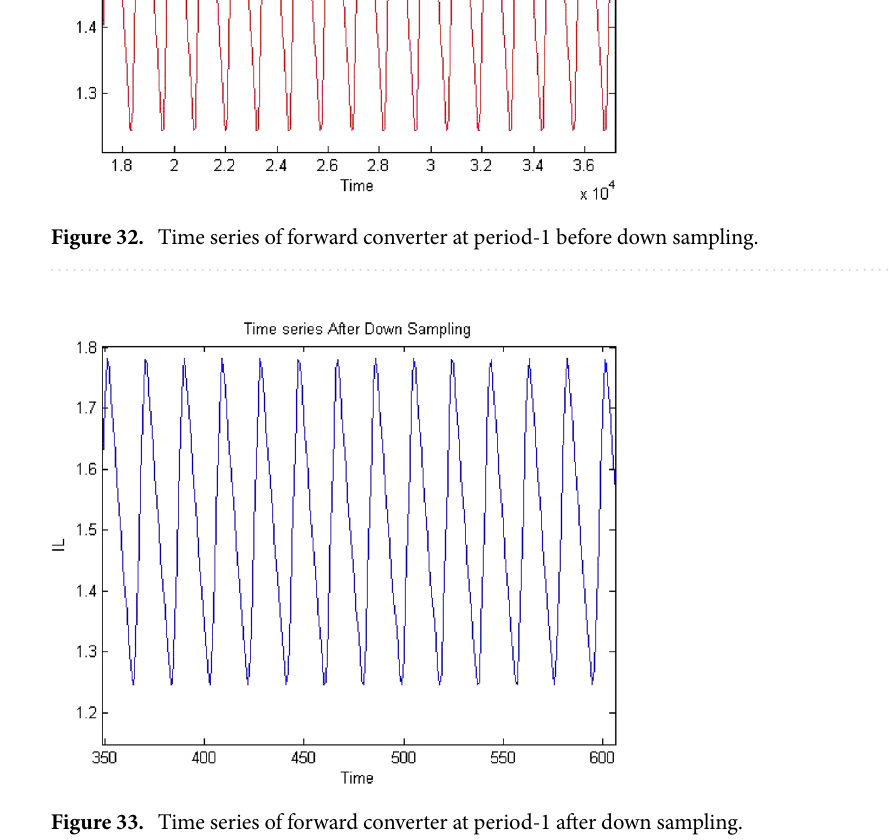
Figure 33. Time series of forward converter at period-1 after down sampling.